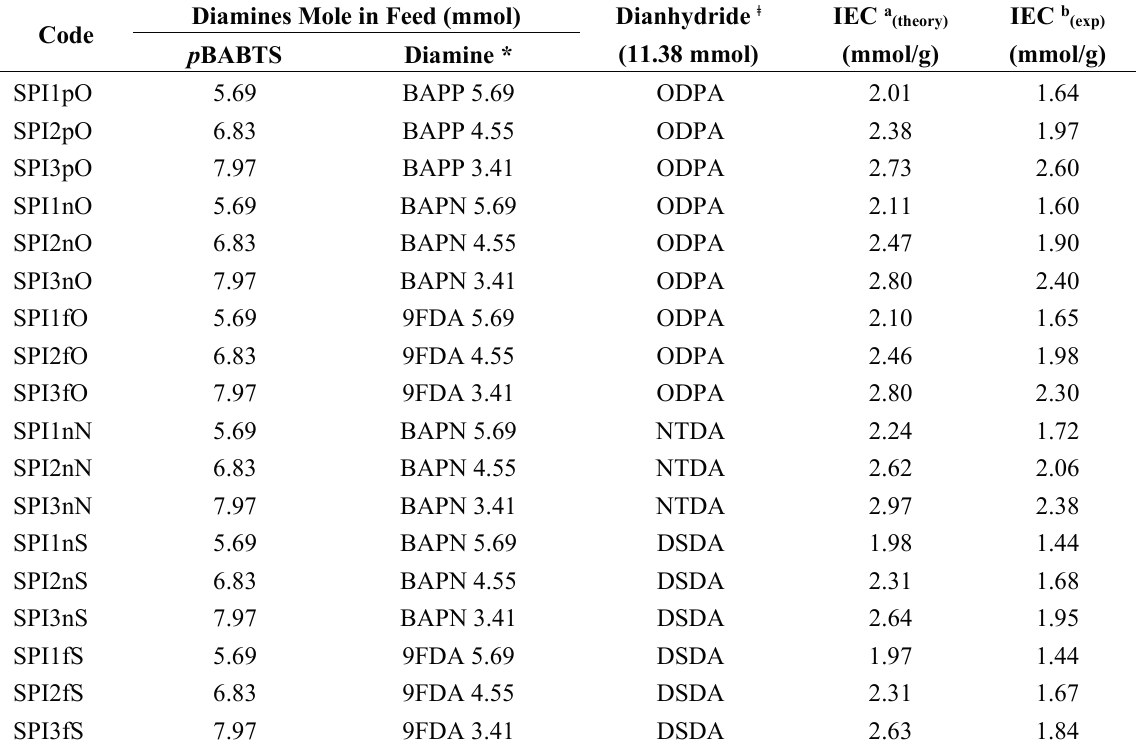
Table 1. The codes, mole fractions in feed and IEC of various sulfonated polyimides.